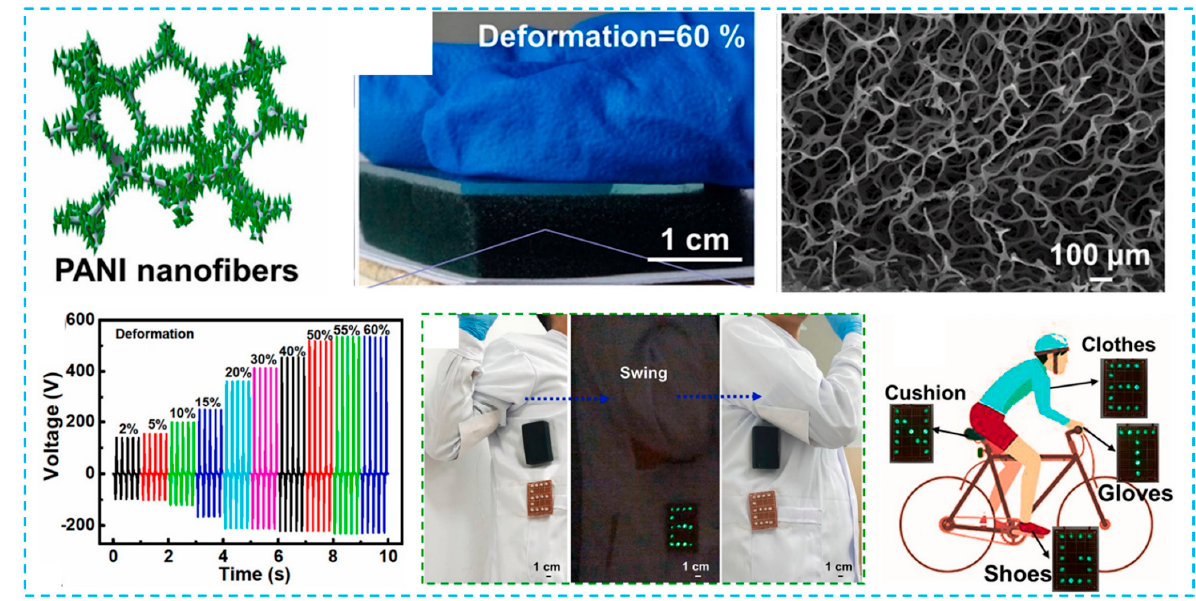
Figure 9. ( a ) Stretchable 3D polymer for simultaneously mechanical energy harvesting and biomimetic force sensing [29]. ( b ) Elastic Cu@PPy sponge for hybrid device with energy conversion and storage [27].